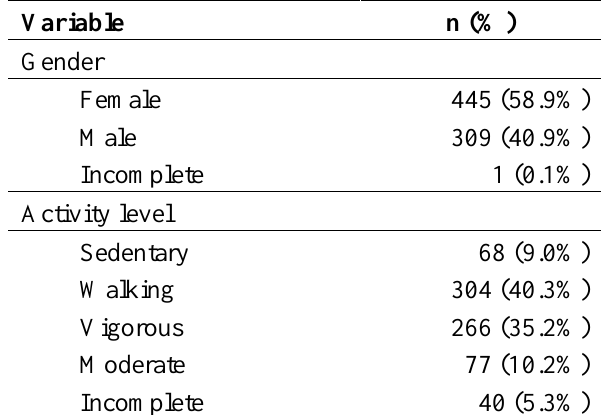
Table 2. Demographics of older adult (age 60+) participants